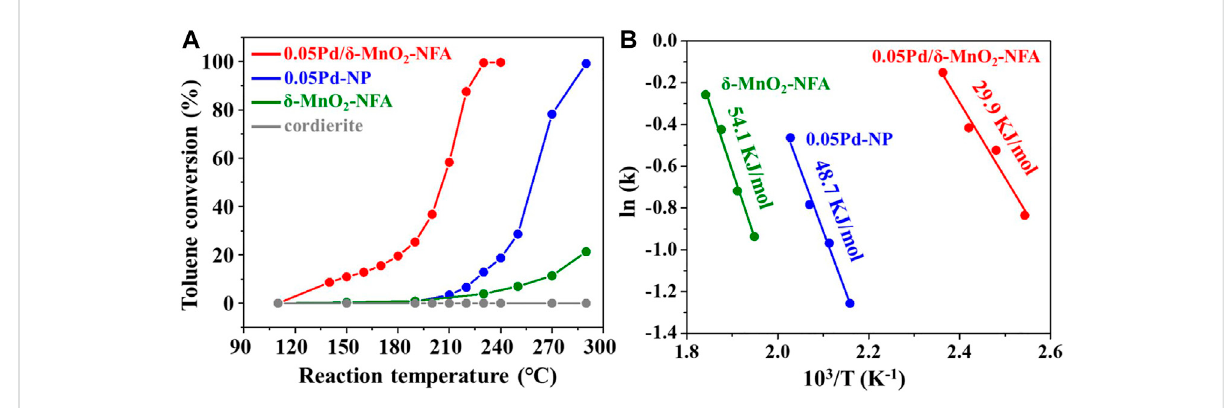
FIGURE 3 (A) Tolueneconversionoverallthemonolithicsamples; (B) Arrheniusplots(tolueneconversionbelow15%)over0.05Pd/ δ -MnO 2 -NFA,0.05Pd- NP, and δ -MnO 2 -NFA samples.